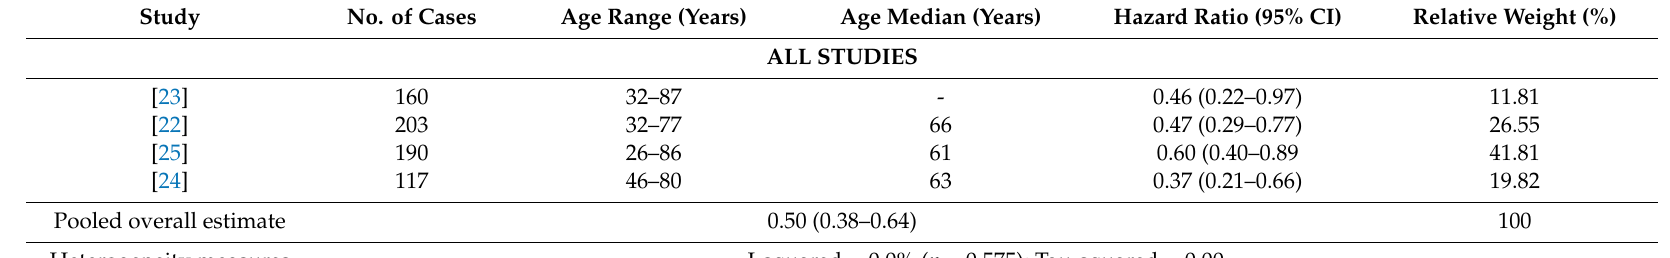
Table 5. Meta-analysis of the association between VM and